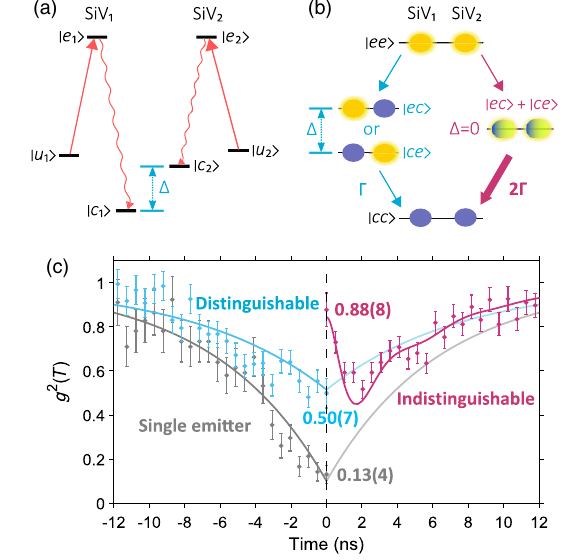
FIG. 4. Observation of the superradiant entangled state using strain control. (a) Level structure for two SiV centers. Strain tuning of one SiV color center changes the detuning ( Δ ) between their j e i to j c i transitions. Separate lasers are applied to excite the j u i to j e i transition of each emitter. (b) A single photon emitted from the two excited emitters with distinguishable transitions ( Δ ≠ 0 ) projects the system to a statistical mixture of j ec i and j ce i states (blue decay path). When the emitters are indistin- guishable ( Δ ¼ 0 ), the emission of one photon projects the system into a superradiant bright state (purple decay path) that decays at a rate 2 times faster than that of the statistical mixture. (c) The second-order photon correlation function is measured for a single emitter (left-hand panel, gray data points) and for two spectrally distinguishable emitters (left-hand panel, blue data points). Measured g ð 2 Þ ð 0 Þ is 0.13(4) and 0.50(7) for the single emitter and distinguishable cases, respectively. Exponential curves fit to the data are plotted and mirrored onto the right half of the plot (gray and blue lines). For two emitters tuned into resonance, we observe the generation of a superradiant entangled state, signified by the peak in the photon correlation (right-hand panel, purple data points). Data are overlaid with a simulated model with a single fit parameter (see Appendix D). For indistinguishable emitters, we measure g ð 2 Þ ð 0 Þ ¼ 0 . 88 ð 8 Þ , limited primarily by detector